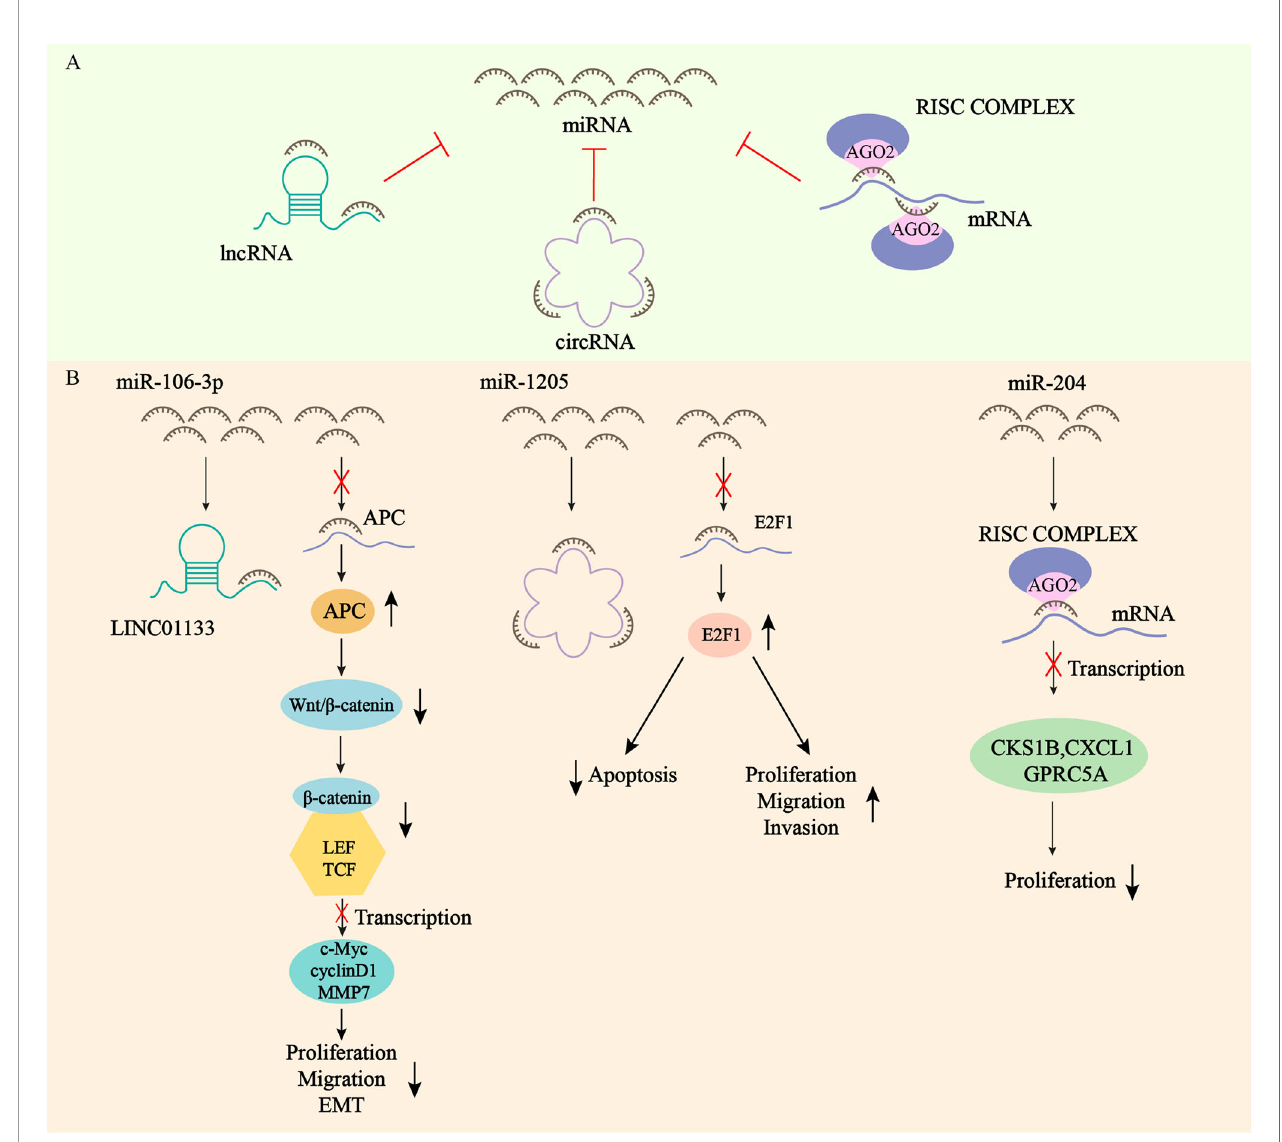
FIGURE 1 | Network of competitive endogenous RNAs. (A) mRNAs, lncRNAs, and circRNAs all contain microRNA (miRNA) response elements (MREs) that can bind to miRNAs and regulate the expression of RNA targets at the post-transcriptional level. (B) LINC01133 exerts oncogenic effect by acting as a sponge for miR- 106-3p, which regulates the expression of APC and inactivates the Wnt/ b -catenin signaling pathway. circCYFIP2 exerts oncogenic effect by acting as a sponge for miR-1205, which regulates the expression of E2F1. miRNA-204 inhibits the transcription of CKS1B, CXCL1 and GPRC5A mRNAs by binding to AGO2 to form the RISC complex, which ultimately inhibits the proliferation of